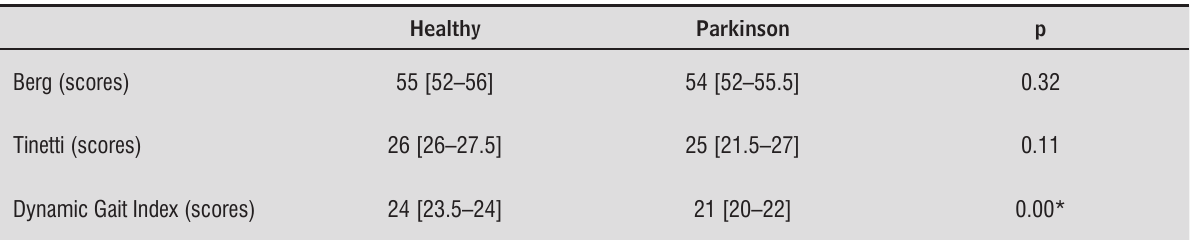
Table 2 - Assessment of Balance and Gait in healthy individuals and individuals with Parkinson’s disease: median and